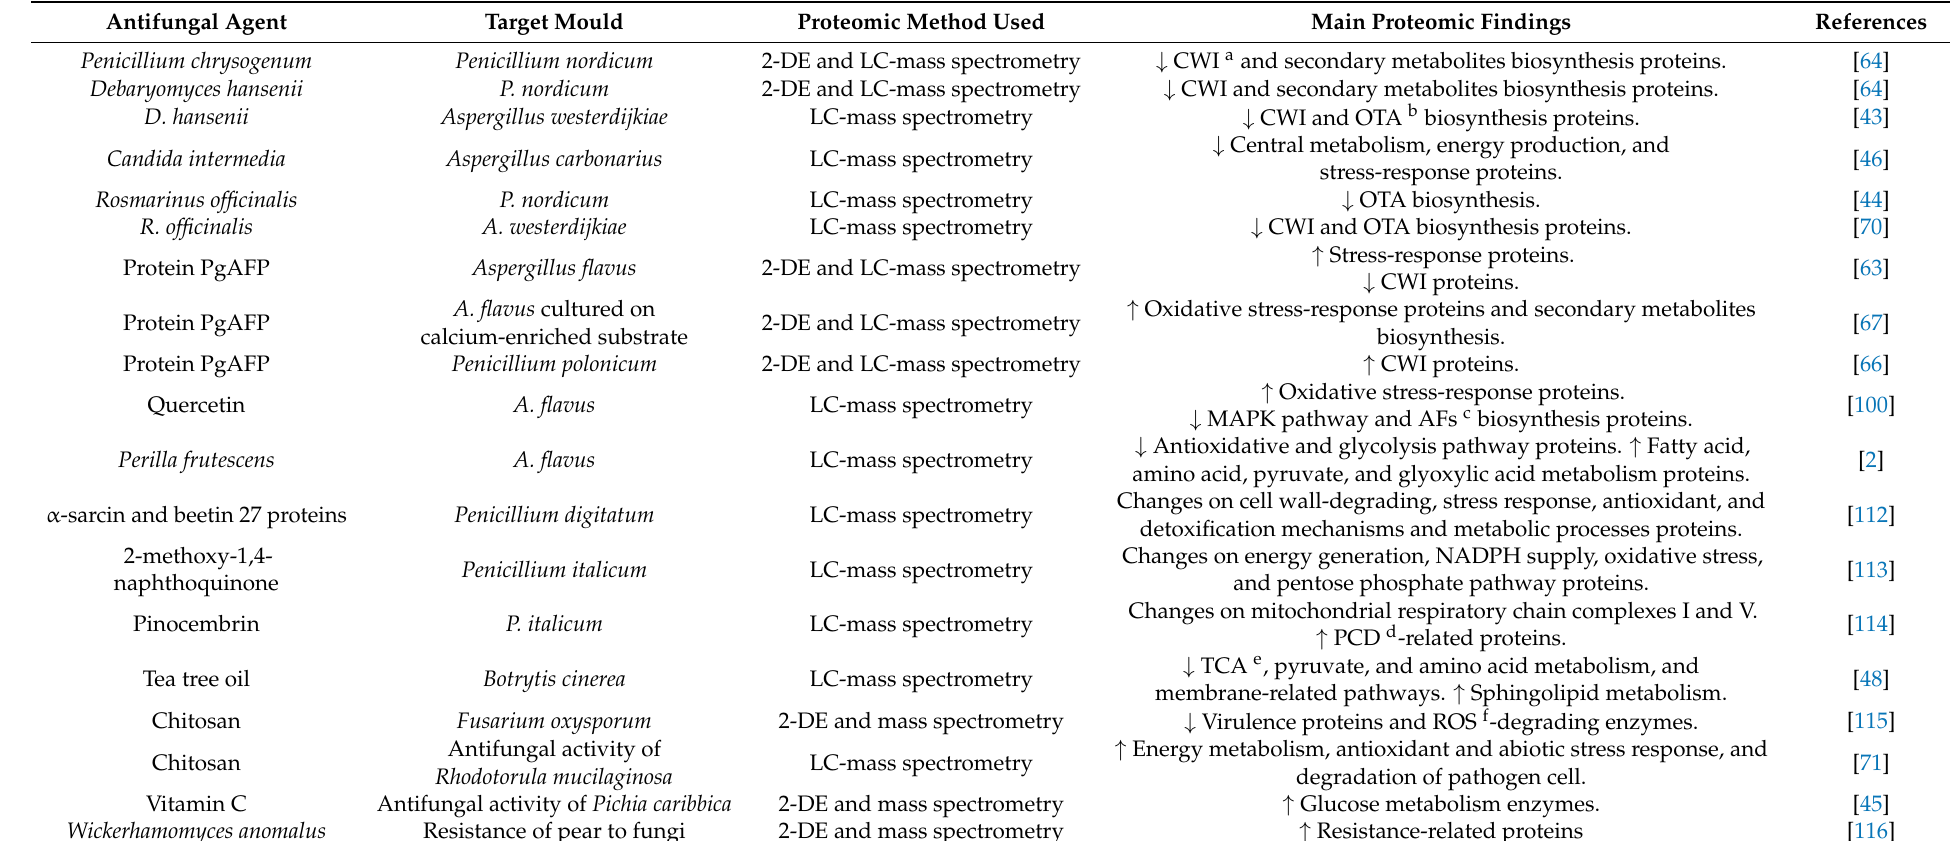
Table 3. Changes induced by control agents in the proteome of undesirable foodborne